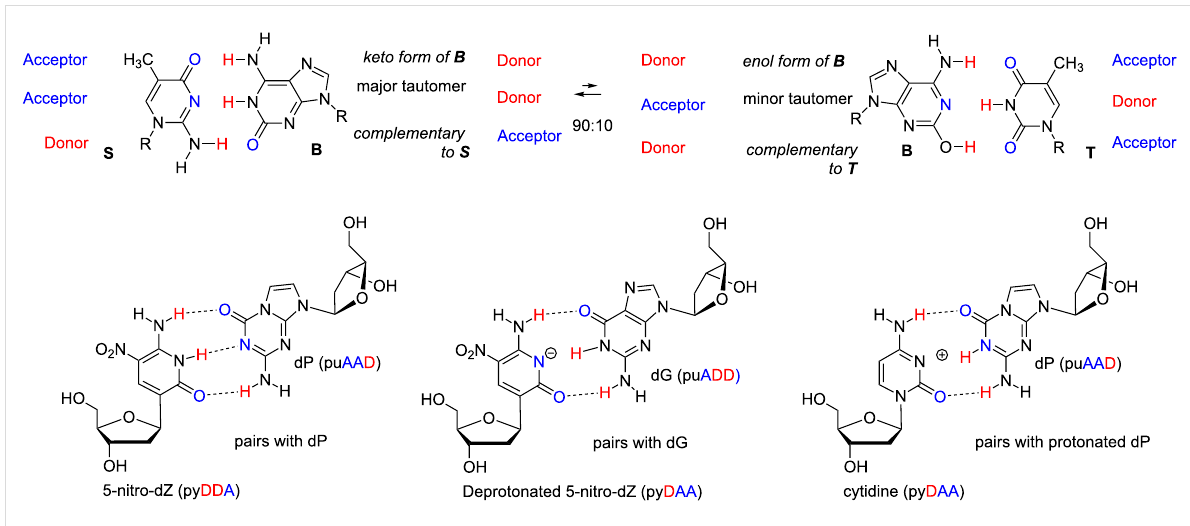
Figure 3: (top) The conversion of S : B pairs to T:A pairs involves tautomerization of B to give its minor enol form, which present a hydrogen bond Donor–Acceptor–Donor pattern complementary to T. If a strand containing B is copied by a polymerase that is not given any d S TP, mismatching of T opposite a minor enol tautomer of B leads (after two cycles of copying) to the replacements of S : B pairs by T:A pairs. (bottom) The conversion of Z : P pairs to C:G pairs involves the mismatching of C opposite a protonated P , and/or the mismatch of deprotonated Z opposite G. Thus, if a strand containing Z is copied at high pH by a polymerase that is not given any d P TP, mismatching of G opposite deprotonated Z leads (after two cycles of copying) to the replacements of Z : P pairs by C:G pairs. Conversely, if a strand containing P is copied at low pH by a polymerase that is not given any d Z TP, mismatching of G opposite protonated P leads (after two cycles of copying) to the replacements of Z : P pairs by C:G